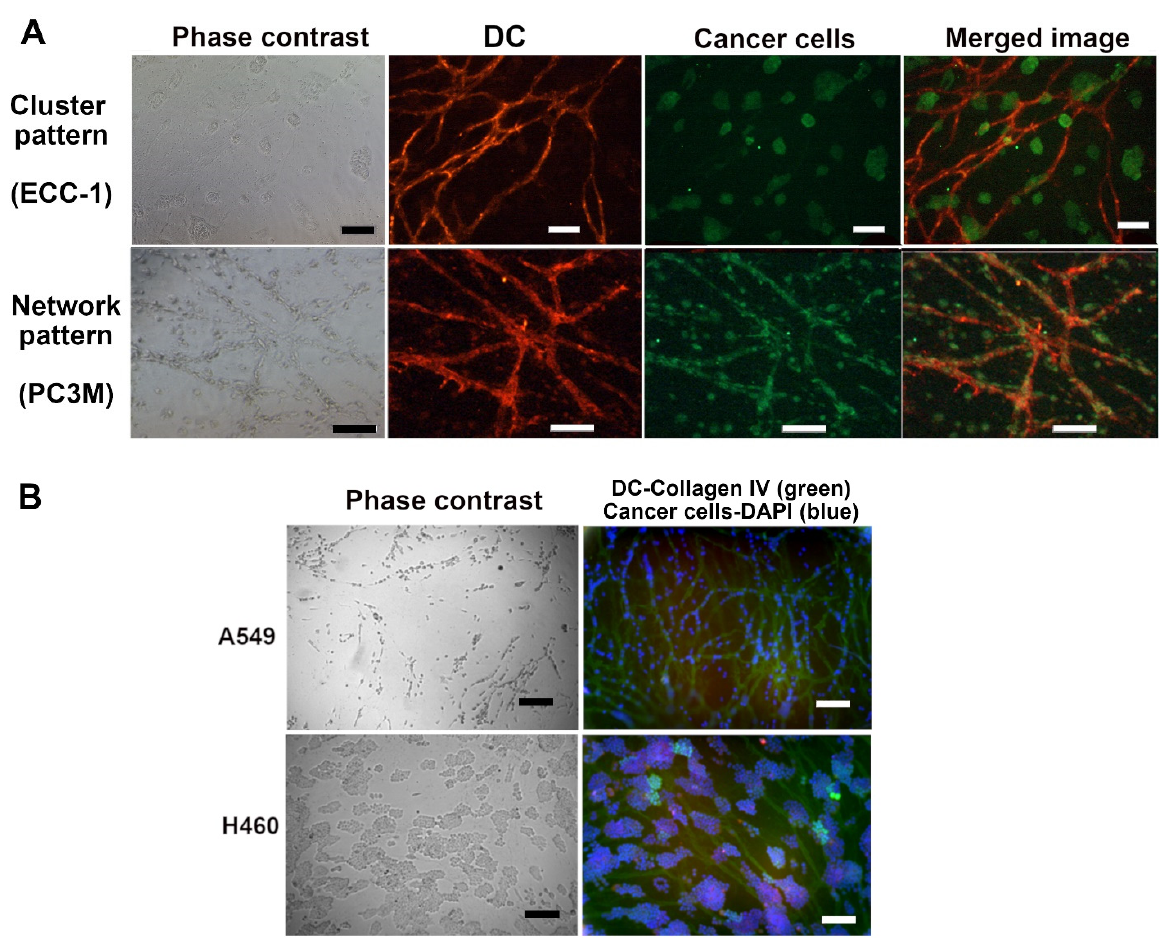
Figure 3. Growth pattern and immunostainings of cancer cell lines on decellularized capillaries. ( A ) Phase-contrast images show that SH-SY5Y forms loose clusters, ECC-1 forms clusters, and PC3M forms networks. Merged images show the co-localization of the network pattern (formed by cancer cells) with the DC. Clusters appear to localize more randomly by preferring proximity to capillary network. DC is stained with anti- von Willebrand factor (red) or with anti-Collagen IV (green). Cancer cells are stained with anti- α -Actin (green) or anti-ALDH1A1 (red). Imaged with Nikon Eclipse Ti-s inverted fluorescence microscope. ( B ) A549 co-localize with capillaries, and H460 cells form clusters. Left: the phase contrast image, right: the immunostained image of the culture; vascular basal membrane (Collagen IV, green) and Nuclei (DAPI, blue). Growth pattern of A549 (network) and H460 (cluster) are seen clearly in both images. Cancer cells are easily visualized with DAPI because capillaries no longer contain DNA. Scale bar 100 µm in all images.